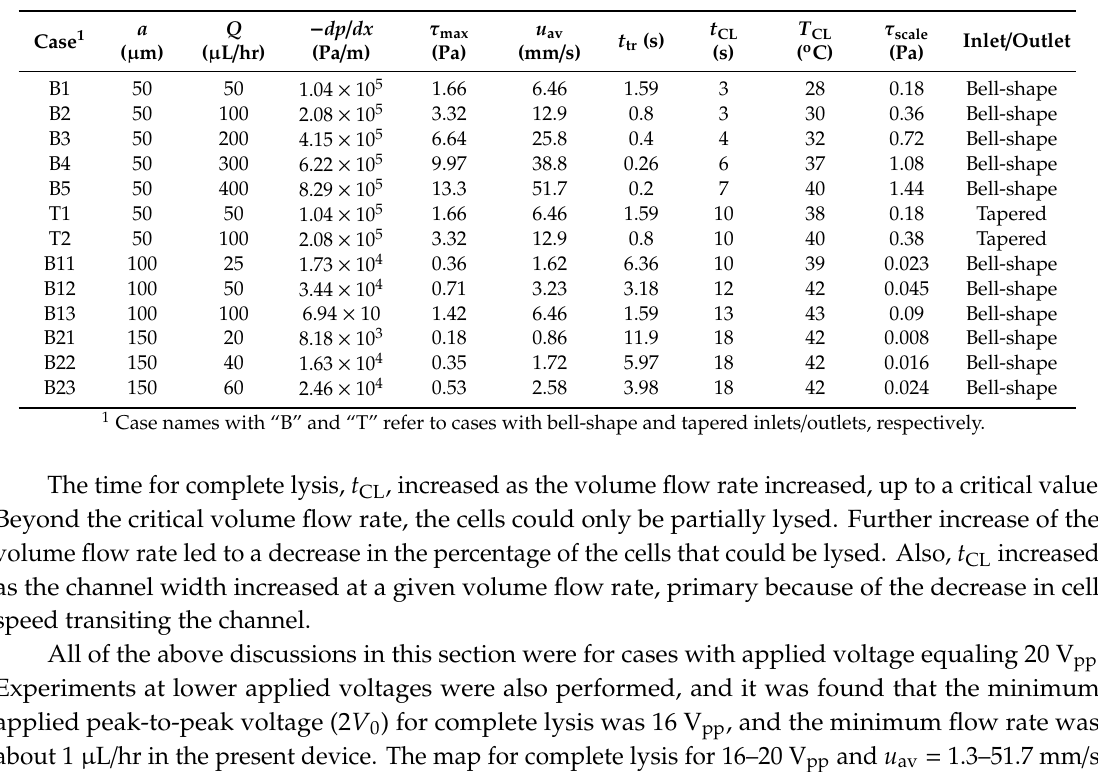
Table 1. Summary of the experiments for complete lysis of human blood cells under 20 V pp and 1